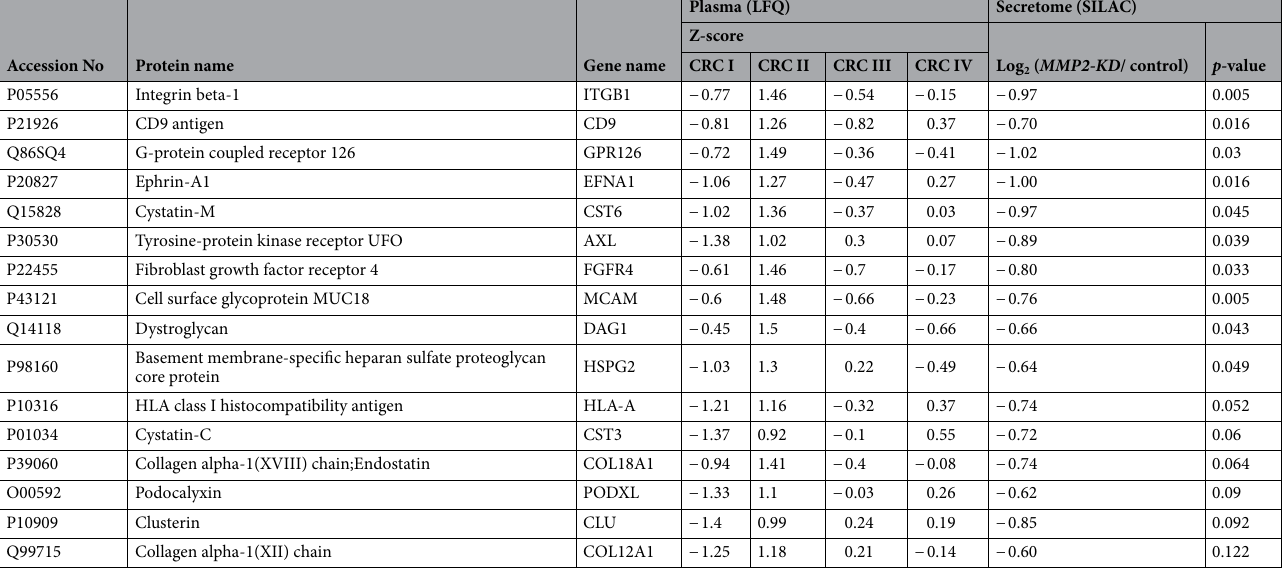
Table 1. List of the 16 proteins that show decreased secretion by MMP2 KD in CRC cells and increased levels in the plasmas of CRC patients during disease progression from stage I to